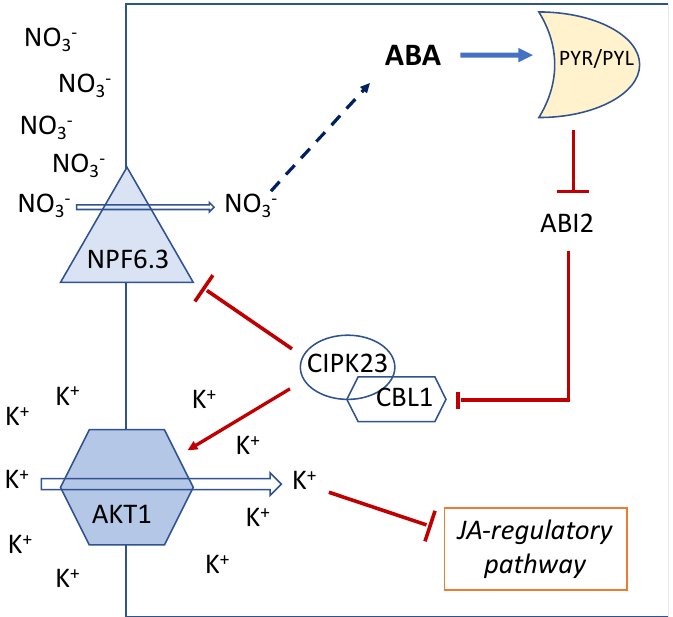
Figure 3. Schematic representation of functional links between NO 3 − and K + uptake via the action of CBL/CIPK complex. Under high levels of exogenous NO 3 − , the CIPK23/CBL1 complex is set free to phosphorylate AtNPF6.3 and AtKAT1 thus leading to a decrease in NO 3 − influx and oppositely an increase in K + influx. It is proposed that the increased K + concentration inhibits JA-regulatory pathway of defense against pathogens. The latter is known to be up-regulated during K + deficiency and inhibited upon K + resupply [57–61].